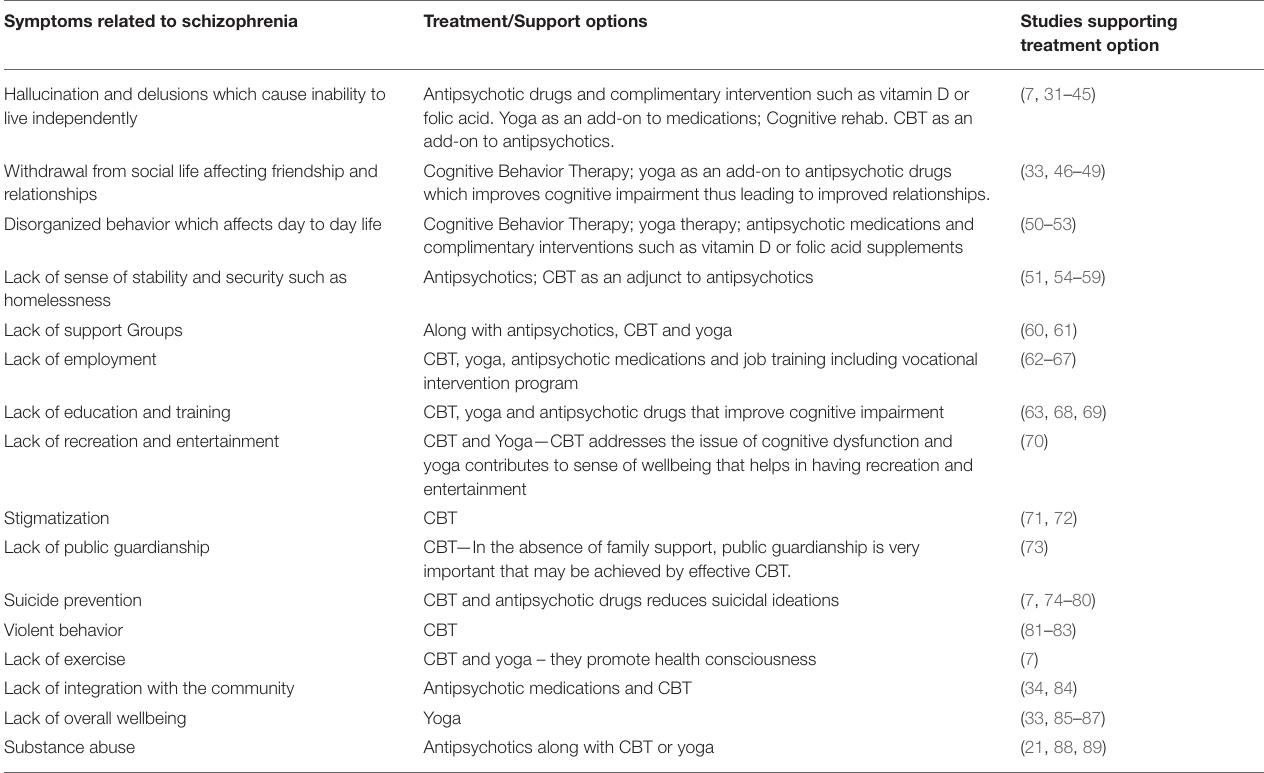
TABLE 1 | The relationship between different symptoms and problems individuals with schizophrenia face, and how these can be managed using pharmacological and non-pharmacological